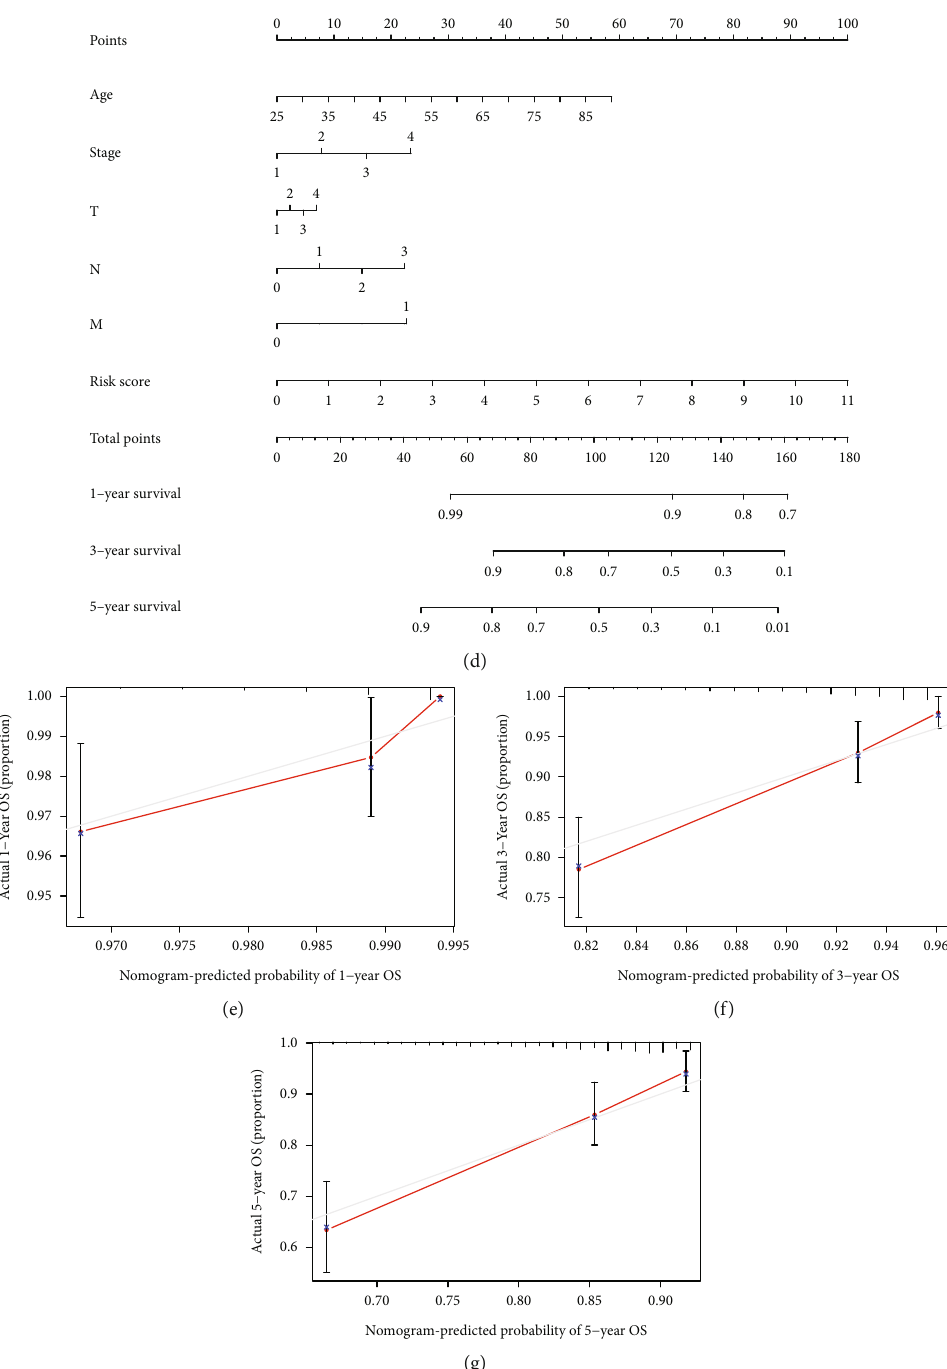
Figure 5: Risk scores became independent predictors of prognosis and constructed patient prognostic nomogram. Univariate (a) and multivariate (b) analyses were performed to observe the association between clinical-pathological elements and overall survival. (c) The ROC curve of age; stage; T, N, M stage; and risk score with OS for BRCA cohorts. A clinical prognostic nomogram (d) was developed to predict survival time. Calibration curves showing the nomogram projections for 1-year (e), 3-year (f), and 5-year (g)